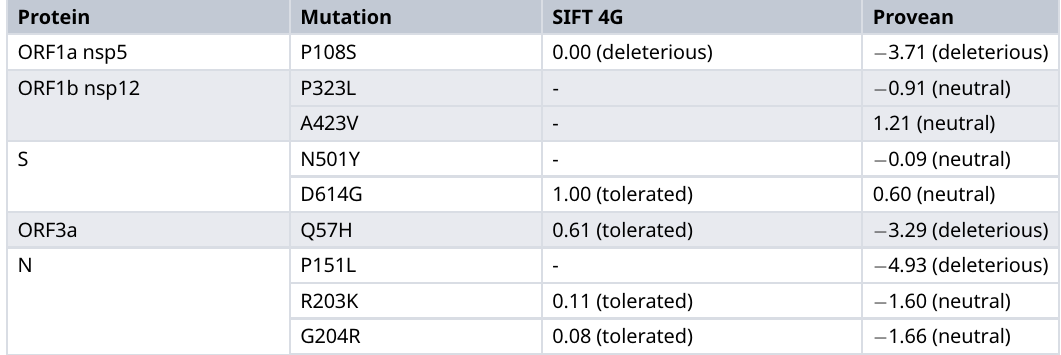
Table 5. Prediction of nonsynonymous mutation effect on SARS-CoV-2 proteins